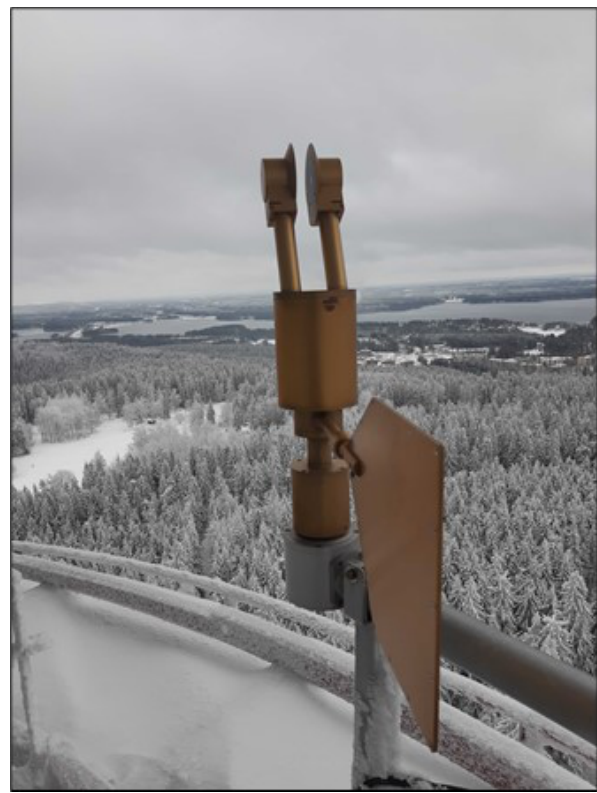
Figure 1. ICEMET sensor located in Puijo tower. The height of the ICEMET sensor is 53cm and the weight is 8kg. The wind wing is used to align the sensor according to the wind direction. (Photo credit: Ari Leskinen).